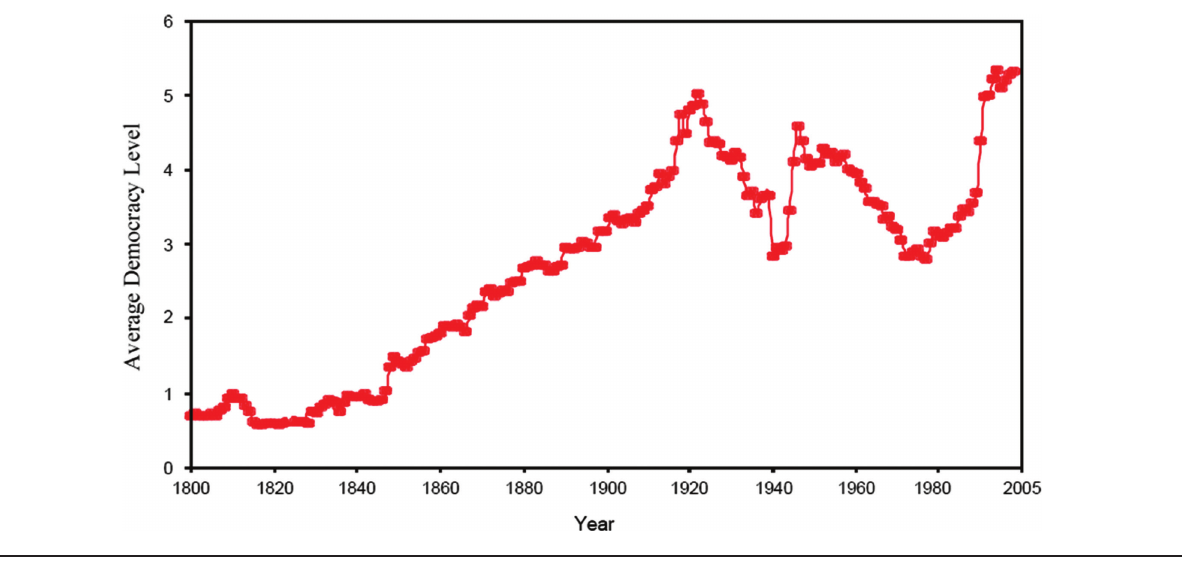
Figure 1. Mean level of democracy across the world, 1800–2005 (Source: data adapted from Marshall and Gurr, 2017, and Wejnert, 2007). Note: Democracy level is assessed on a scale of 0–10, where 0 means non-democracy, and 10 means the top level of democracy on average in the world. Each year, the level of democracy is assessed only for sovereign countries. The study includes the 151 sovereign countries that have available data in the data sets used.